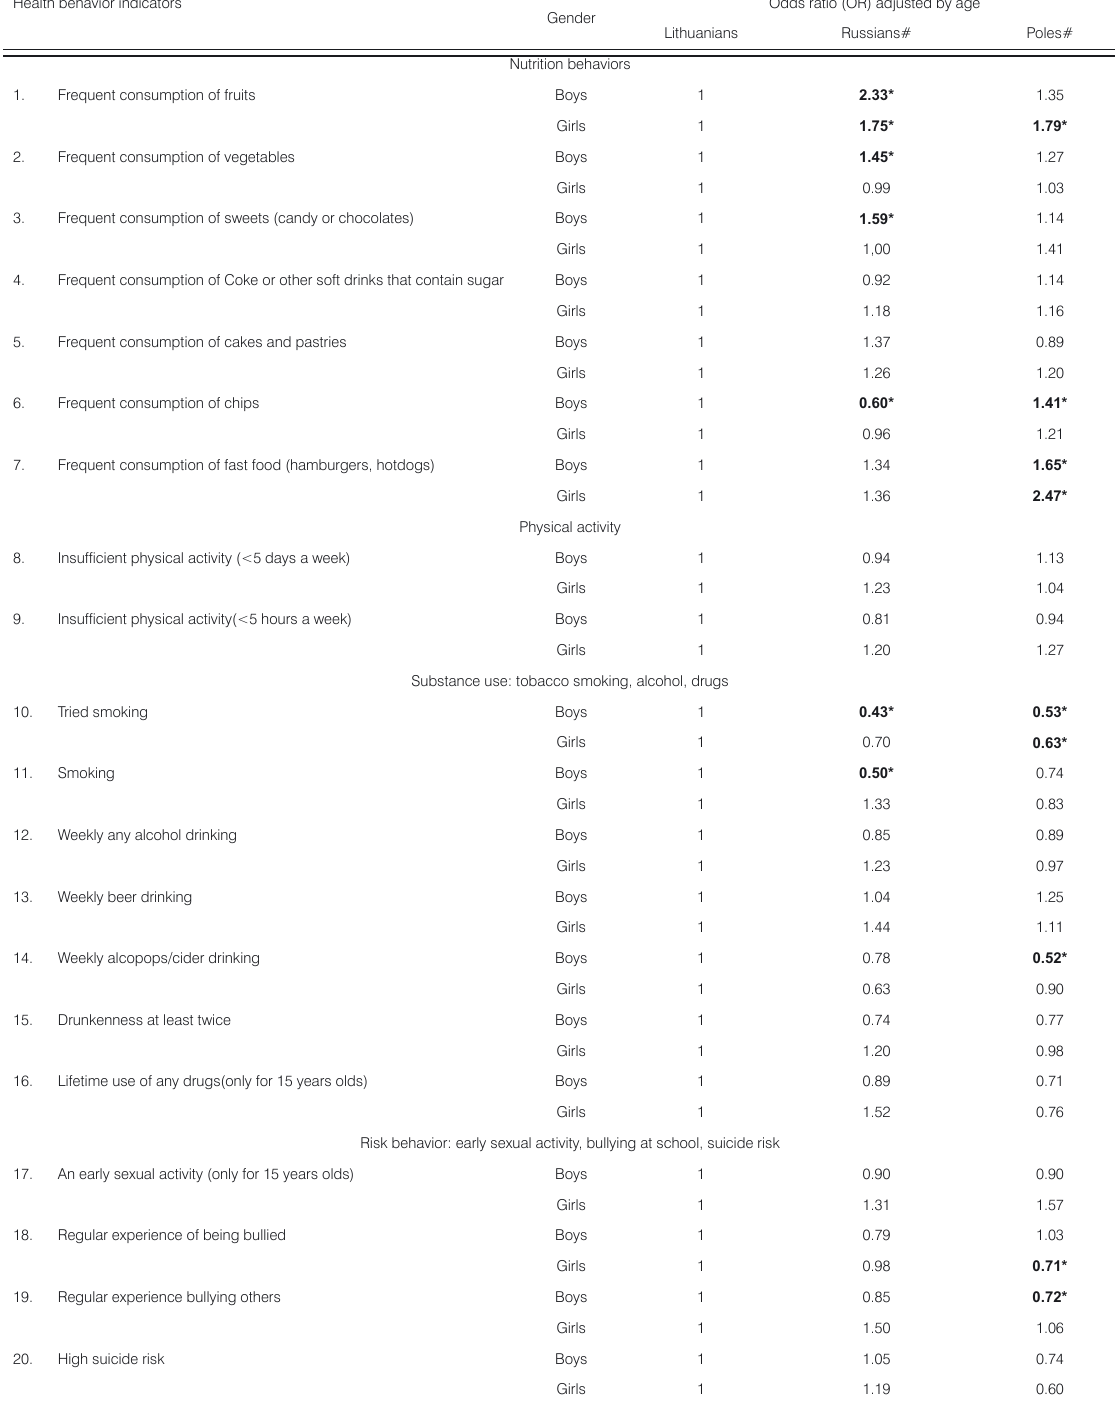
Table 3. Odds ratios for twenty health behavior indicators by nationality and